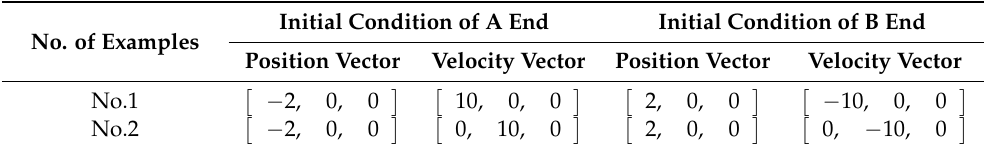
Table 4. The initial condition of two examples.